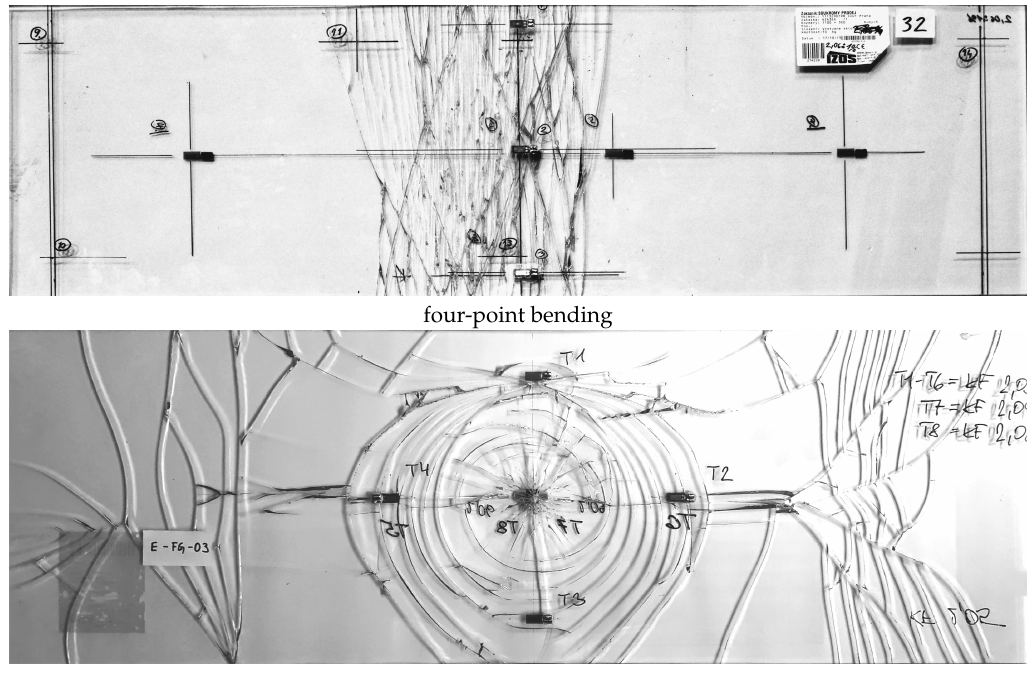
Figure 1. Photos of fracture patterns for laminated glass samples made of float glass with two edge supports after four-point bending with multiple cracks in the middle part or after the low-velocity hard impact of a steel impactor with a hemispherical head resulting in a spider web crack